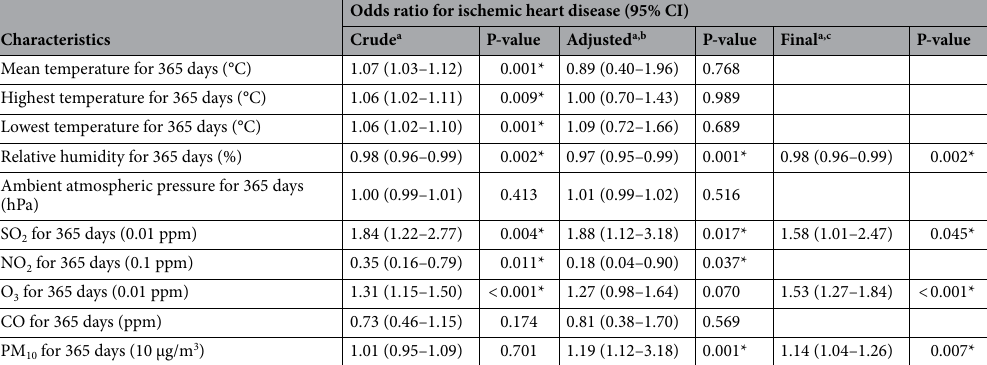
Table 3. Crude and adjusted odd ratios (95% confidence interval) of the meteorological and pollution matter (mean of 365 days before the index date) for ischemic heart disease. *Conditional logistic regression model, Significance at P < 0.05. a Stratified model for age, sex, income, and region of residence. b Adjusted model was adjusted for obesity, smoking status (current smoker compared to nonsmoker or past smoker), frequency of alcohol consumption (≥ 1 time a week compared to < 1 time a week), CCI score, mean temperature, highest temperature, lowest temperature, relative humidity, atmospheric pressure, SO 2 , NO 2 , O 3 , CO, and PM 10 . c Final model was adjusted for obesity, smoking status (current smoker compared to nonsmoker or past smoker), frequency of alcohol consumption (≥ 1 time a week compared to < 1 time a week), CCI score, relative humidity, SO 2 , NO 2 , O 3 , CO, and PM 10 using the backward selection